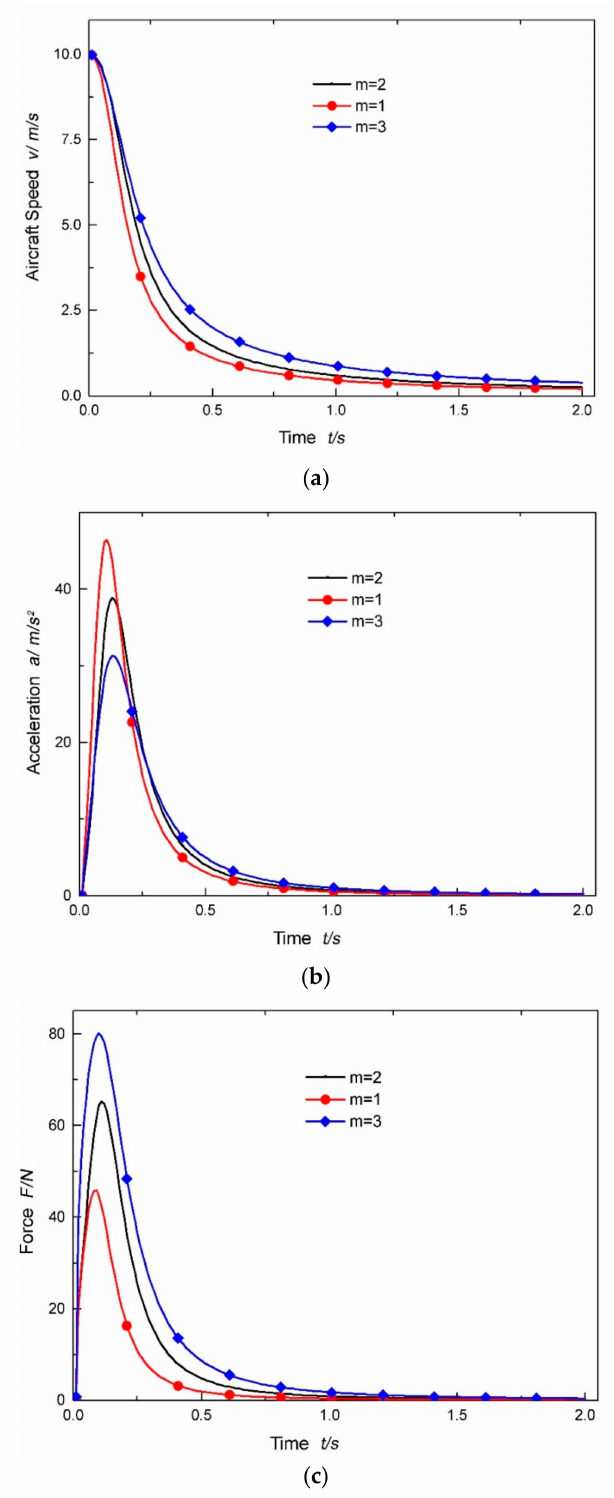
Figure 18. Influence of UAV mass on arresting process. ( a ) The change of UAV velocity, v ; ( b ) the change of UAV acceleration, a ; ( c ) the change of internal force, F c , of the arresting